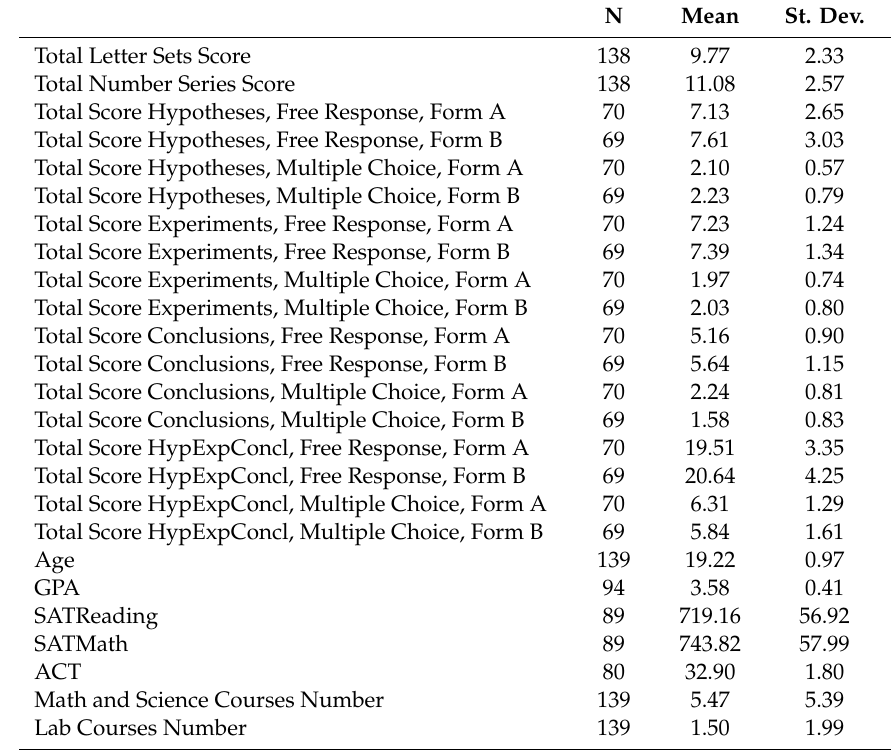
Table 9. Study 2 Mean Scores and Standard